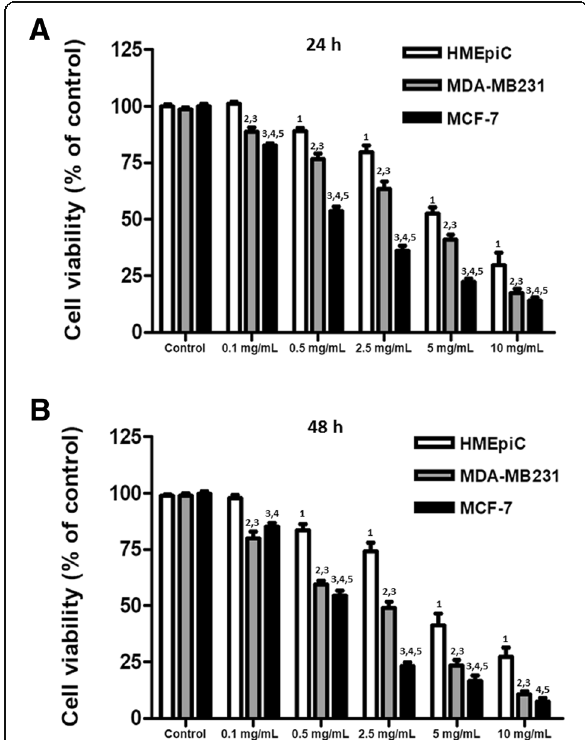
Fig. 1 Effects of T33 on viability of HMEpiC, MDA-MB231 and MCF-7 cells. Relative cell survival rates of HMEpiC, MDA-MB231 and MCF-7 cells after treatment with different concentrations of T33 for a 24 and b 48 h. Similar results were observed in triplicate experiments. The superscripts 1, 2, 3, 4 and 5 refer to significant differences ( P < 0.05) from the HMEpiC control, MDA-MB231 control, HMEpiC, MCF-7 control and MDA-MB231, respectively